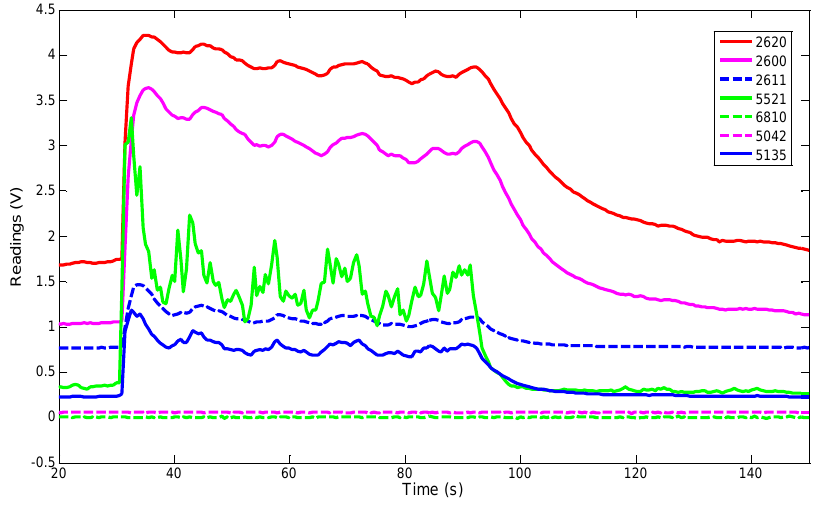
Figure 11. Readings from seven different MOS sensors within a chamber when exposed to